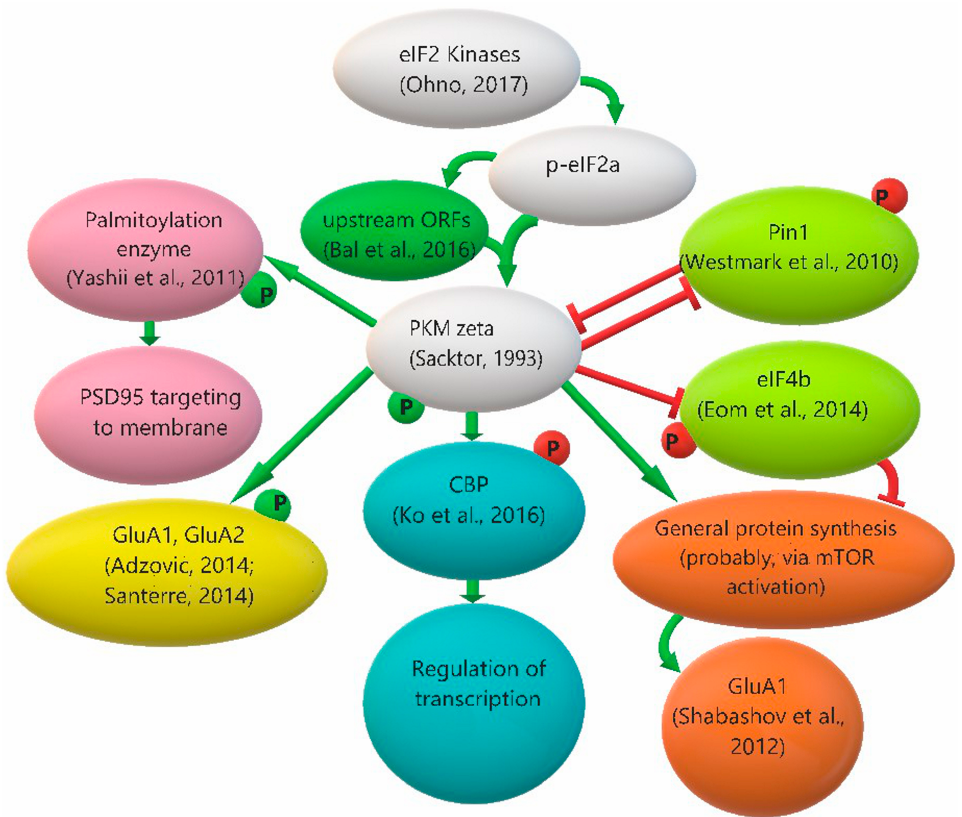
Figure 3. A diagram of PKM ζ kinase regulation and functions. eIF2 - eucaryotic translation initiation factor 2; p-eIF2a - phosphorylated α -subunit of eucaryotic translation initiation factor 2; P - phosphate group; ORF - open reading frame; PKM zeta - protein kinase M ζ ; Pin1 - peptidyl-prolyl cis-trans isomerase NIMA-interacting 1; PSD95 - postsynaptic density protein 95; eIF4b - eucaryotic initiation factor 4B; CBP - CREB-binding protein; GluA1, GluA2 - glutamate ionotropic receptor AMPA type subunits 1 and 2; mTOR - mammalian target of rapamycin. A detailed explanation of this scheme is presented in Sections 3.2 and